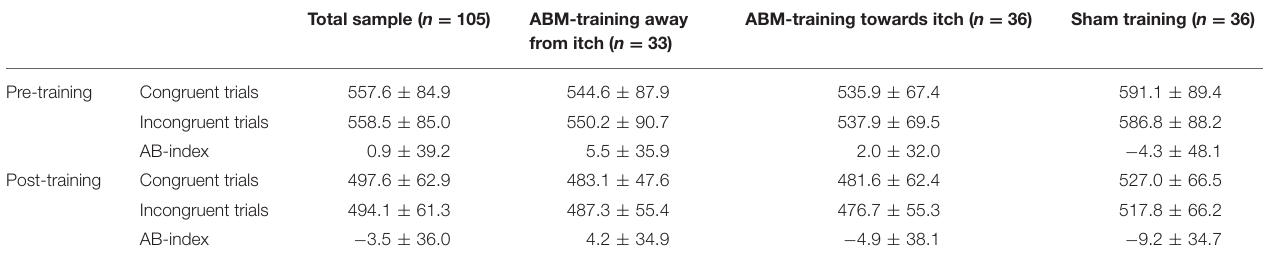
Table 4 | Mean ± standard deviation of reaction times for the trials congruent and incongruent to the itch words of the dot-probe tasks administered pre- and post-training, displayed for the total sample and per attention bias modification (ABM)-training